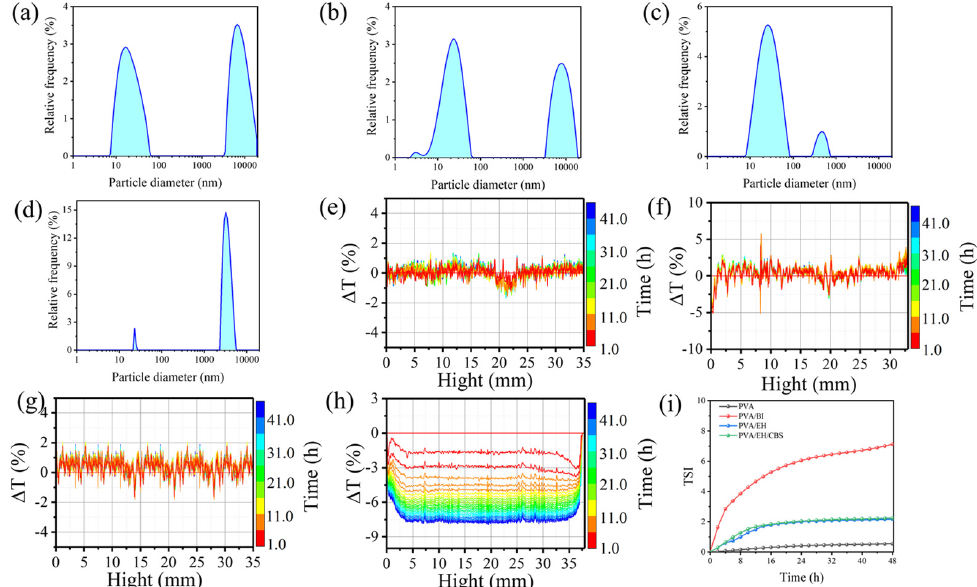
Figure 5. Particle size distribution of of ( a ) PVA solution, ( b ) PVA/EH solution, ( c ) PVA/EH/CBS solution (Na 2 CO 3 /NaHCO 3 molecular ratio = 3:2), ( d ) PVA/BI dispersion and dispersion of the transmitted light scattering curves of ( e ) PVA, ( f ) PVA/EH, ( g ) PVA/EH/CBS, ( h ) PVA/BI, ( i ) TSI change with time (solution concentration 80 g/L and PVA to crosslinking agent mass ratio 1:1).